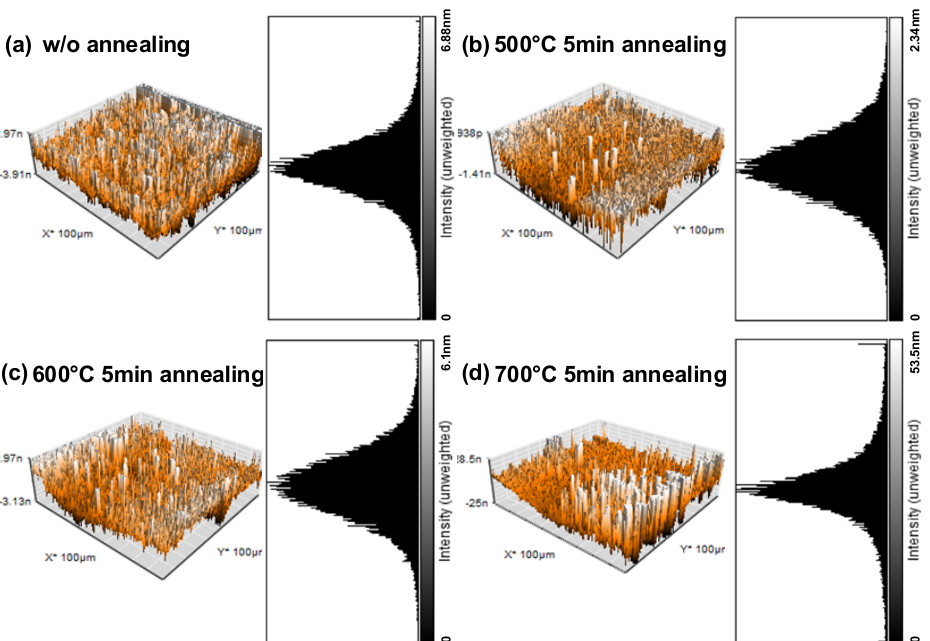
Figure 5. Atomic force microscope images of the surface: ( a ) without annealing; ( b ) after annealing at 500 °C for 5 min; ( c ) after annealing at 600 °C for 5 min; ( d ) after annealing at 700 °C for 5 min.